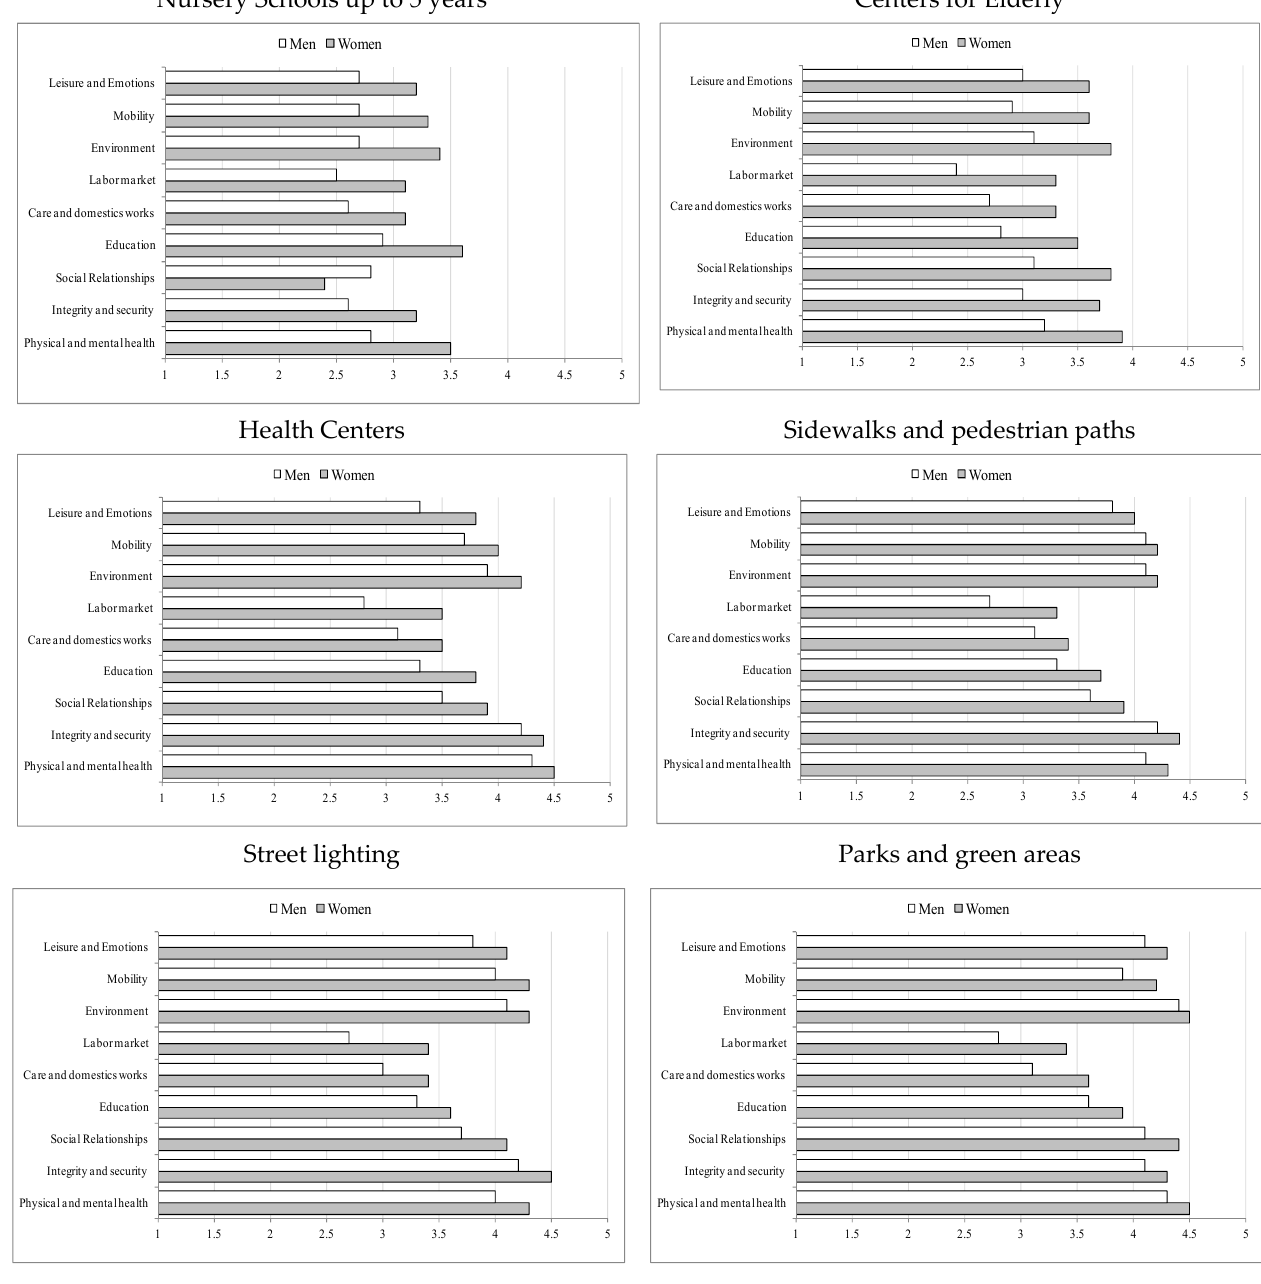
Figure 4. Importance of infrastructure on capabilities by gender. Source: Own elaboration based on FOUM.